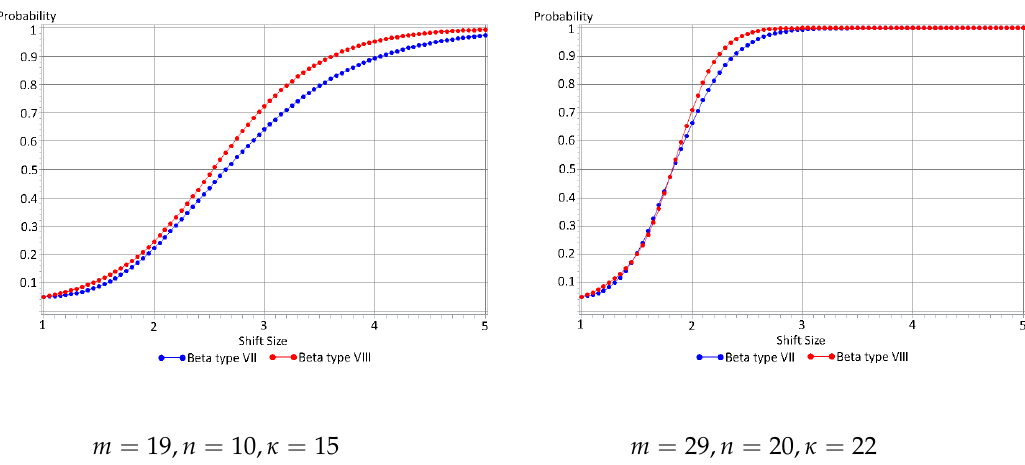
Figure 9. Probability of detecting a shift when κ ≈ 0.75